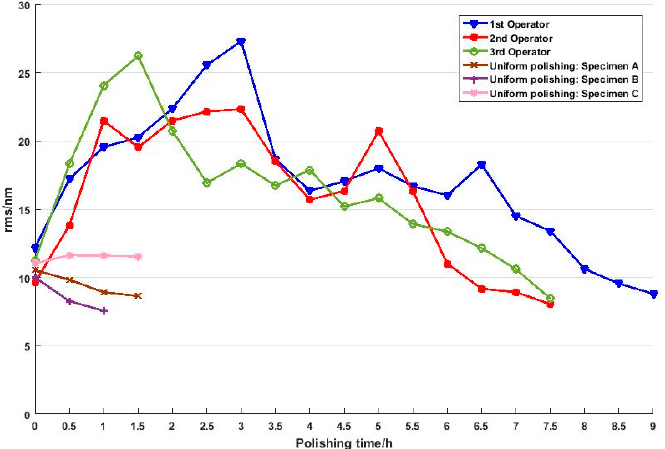
Figure 15. A comparison of experimental results of empirical polishing (test B) and uniform polishing (test C).